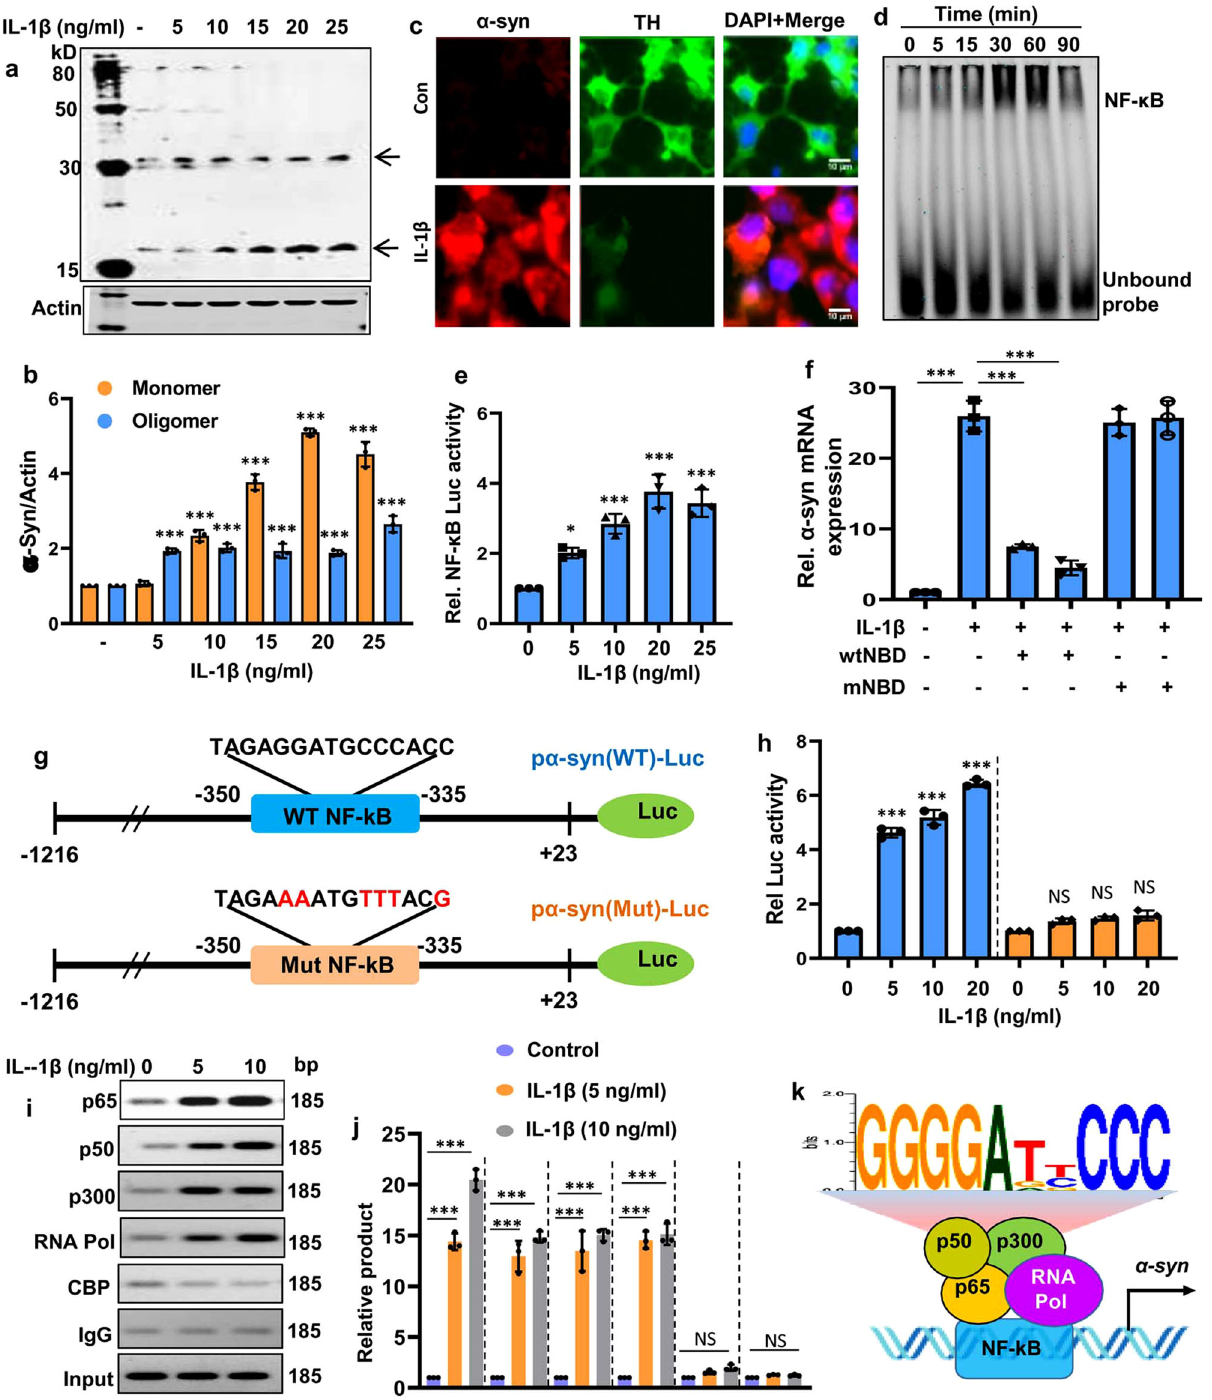
peptide suggests that similar to mouse neuronal cells, IL-1 β also requires NF- κ B to increase α -syn in human neuronal cells (Supplementary Fig. S13d – f). Finally, a signi fi cant amount of p65, p50, p300, and RNA Pol was found to be recruited to the human α -syn promoter in IL-1 β -treated SH-SY5Y cells (Supplementary Fig. S13g, h), highlighting the importance of NF- κ B in IL-1 β - induced transcription of the human α -syn gene. Is activation of NF- κ B suf fi cient for the induction of α -syn expression? In addition to inducing the activation of NF- κ